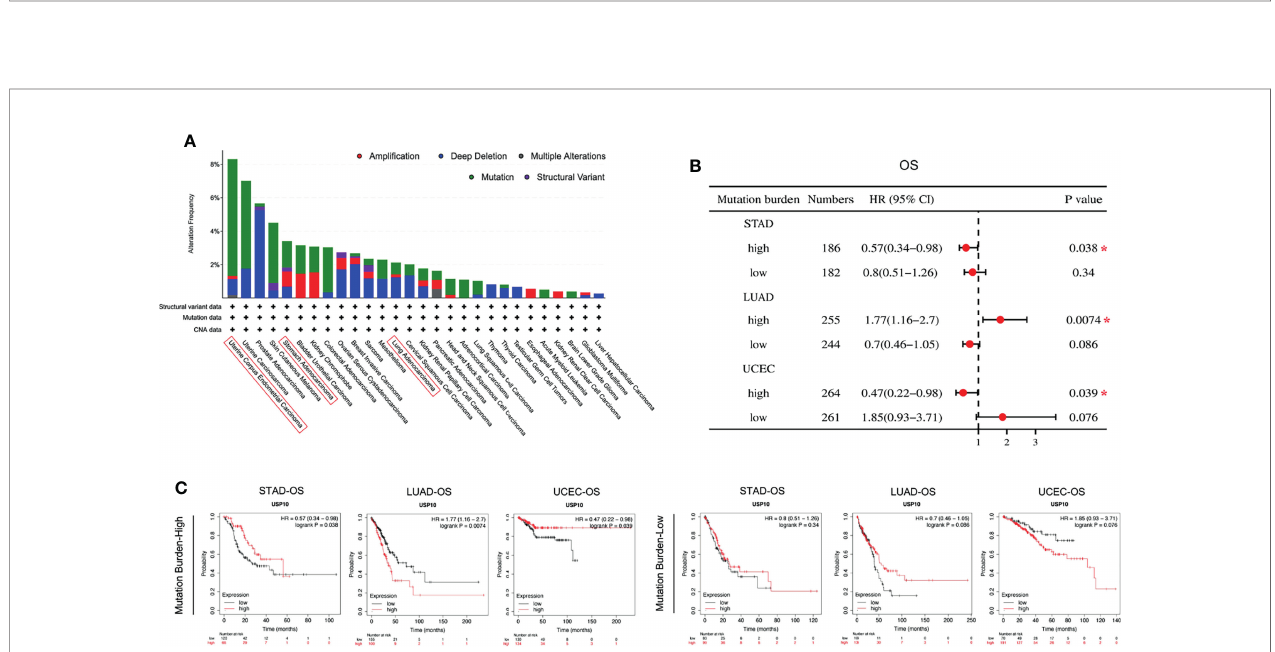
FIGURE 5 | Correlation between USP10 expression and the prognosis of various types of cancer in the Kaplan – Meier Plotter (A – F) and GEPIA (G – I) databases. Overall survival (OS) and relapse-free survival (RFS) survival curves of patients with (A) pancreatic cancer (PAAD), (B) liver cancer (LIHC), (C) breast cancer (BRCA), (D) ovarian cancer (OV), (E) lung squamous cell carcinoma (LUSC), (F) cervical squamous cell carcinoma and endocervical adenocarcinoma (CESC), (G) pancreatic cancer (PAAD), (H) lung adenocarcinoma (LUAD), (I) head and neck squamous cell carcinoma (HNSC). Patients with high USP10 expression are represented by the red curve. Signi fi cance is indicated by a P -value < 0.05.